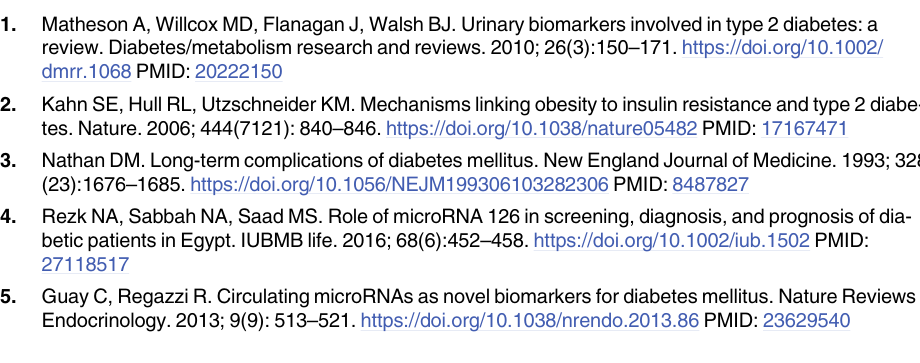
S1 Table. The demographic characteristics of the studied groups. S2 Table. Expression levels of miRNA-122, miRNA-126-3p and miRNA-146a in